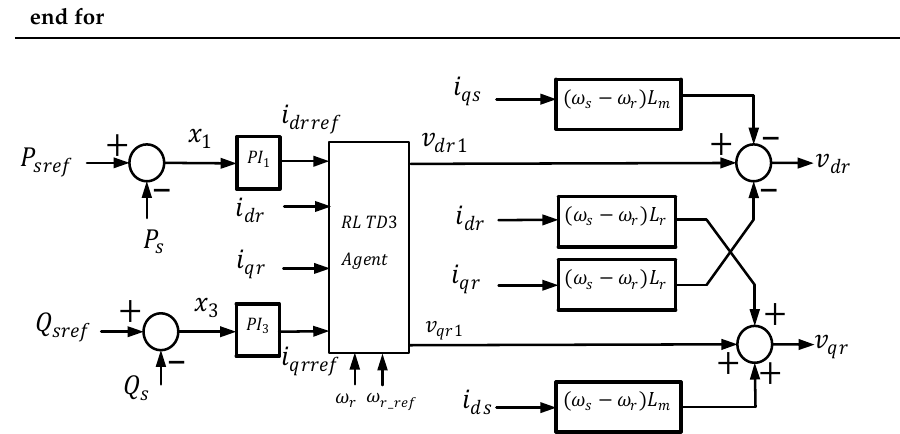
Figure 14. TD3 agent implementation on RSC.